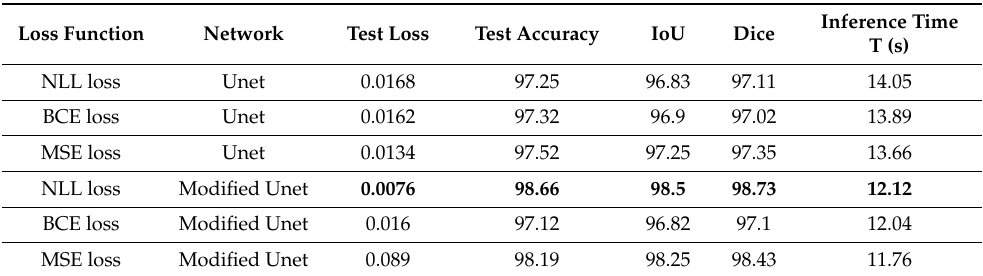
Table 6. Comparative performance of the original U-net and the modified U-net. (Best results are highlighted as